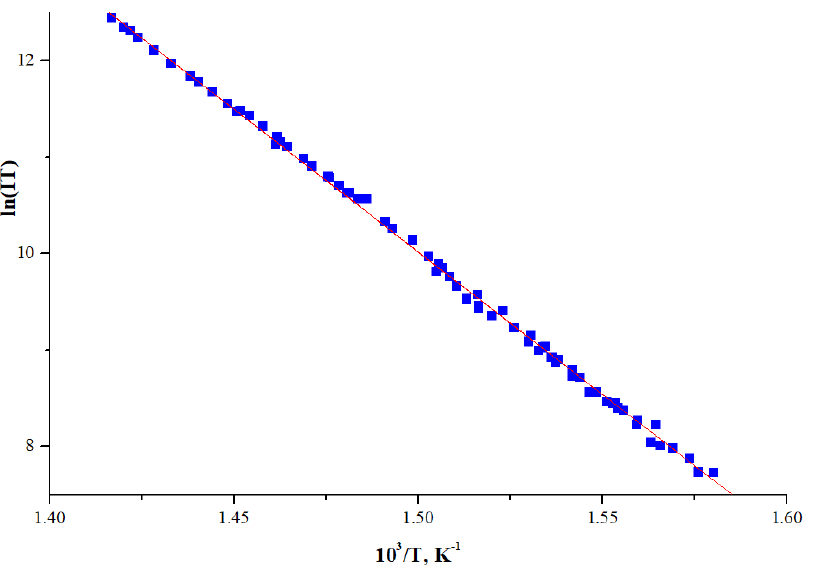
Figure 2. Dependence of the molecular ion intensity logarithm of NiTTDPz on temperature.